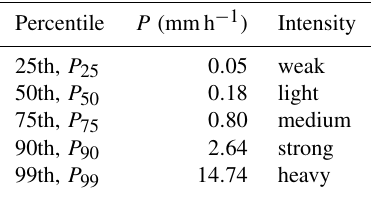
Table 1. Quantitative (mmh − 1 ) and qualitative intensities for each of the five percentiles of OceanRAIN precipitation rate